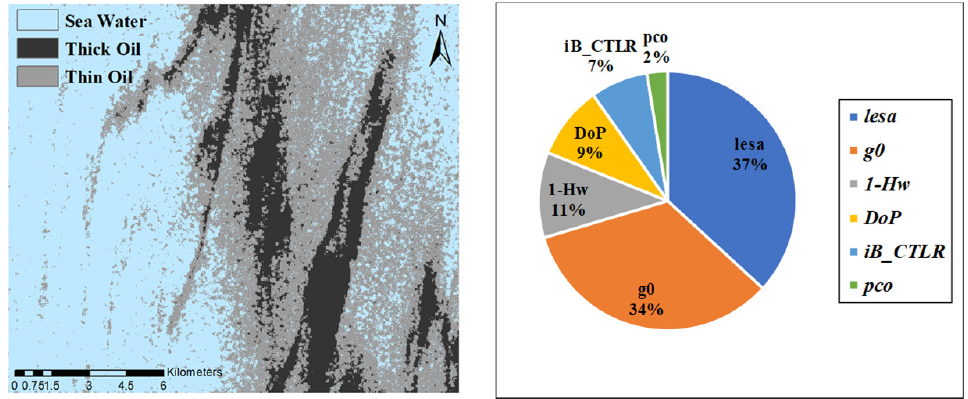
14 of 19 Figure 13. JM distance measurement results: ( a ) Case 1; ( b ) Case 2; ( c , d ) Case 3; ( e ) Case 4; ( f ) Case 5; ( g ) Case 6. 3.4. Comparison of Classification Results Variable importance is a parameter that evaluates how much each factor contributes to the classification result. After we extracted the feature maps of study area using the 𝑙 𝑒𝑠𝑎 , we performed random forest classification on the feature maps. Figure 14 and Figure 15 show the classification of oil slicks with different thicknesses and their respective variable importance rankings in Case 1 and Case 2, respectively. Table 3 and Table 4 show the respective producer and user accuracy results. The kappa coeffi- cient can be used to evaluate classification accuracy [19]. It can be seen from the classifi- cation results that the distinction between the thin oil film and seawater in the right half